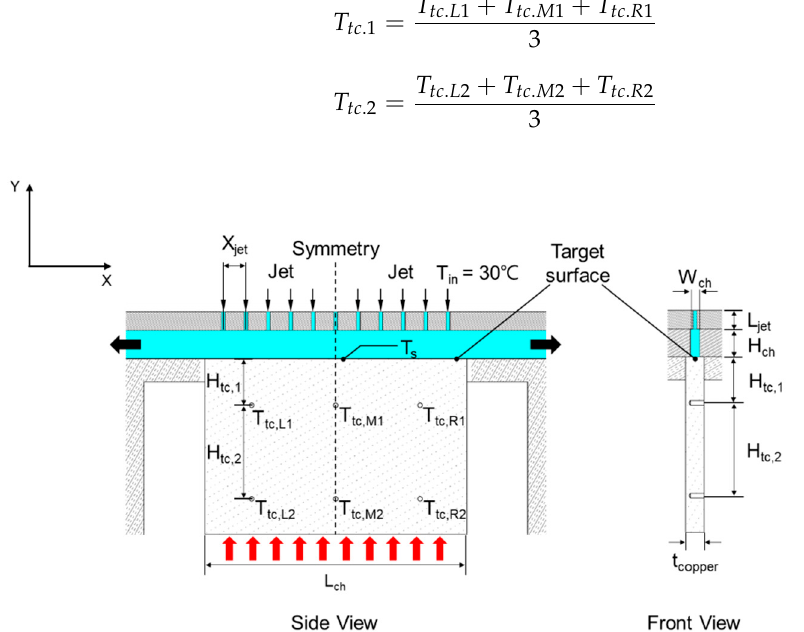
Figure 3. Schematic of side and cross-sectional views of test section.